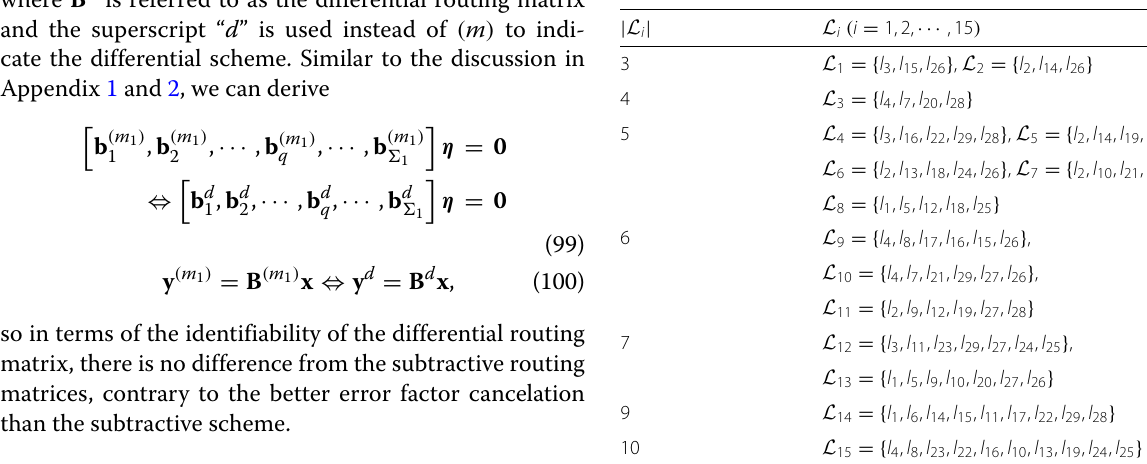
Table 1 Sets of